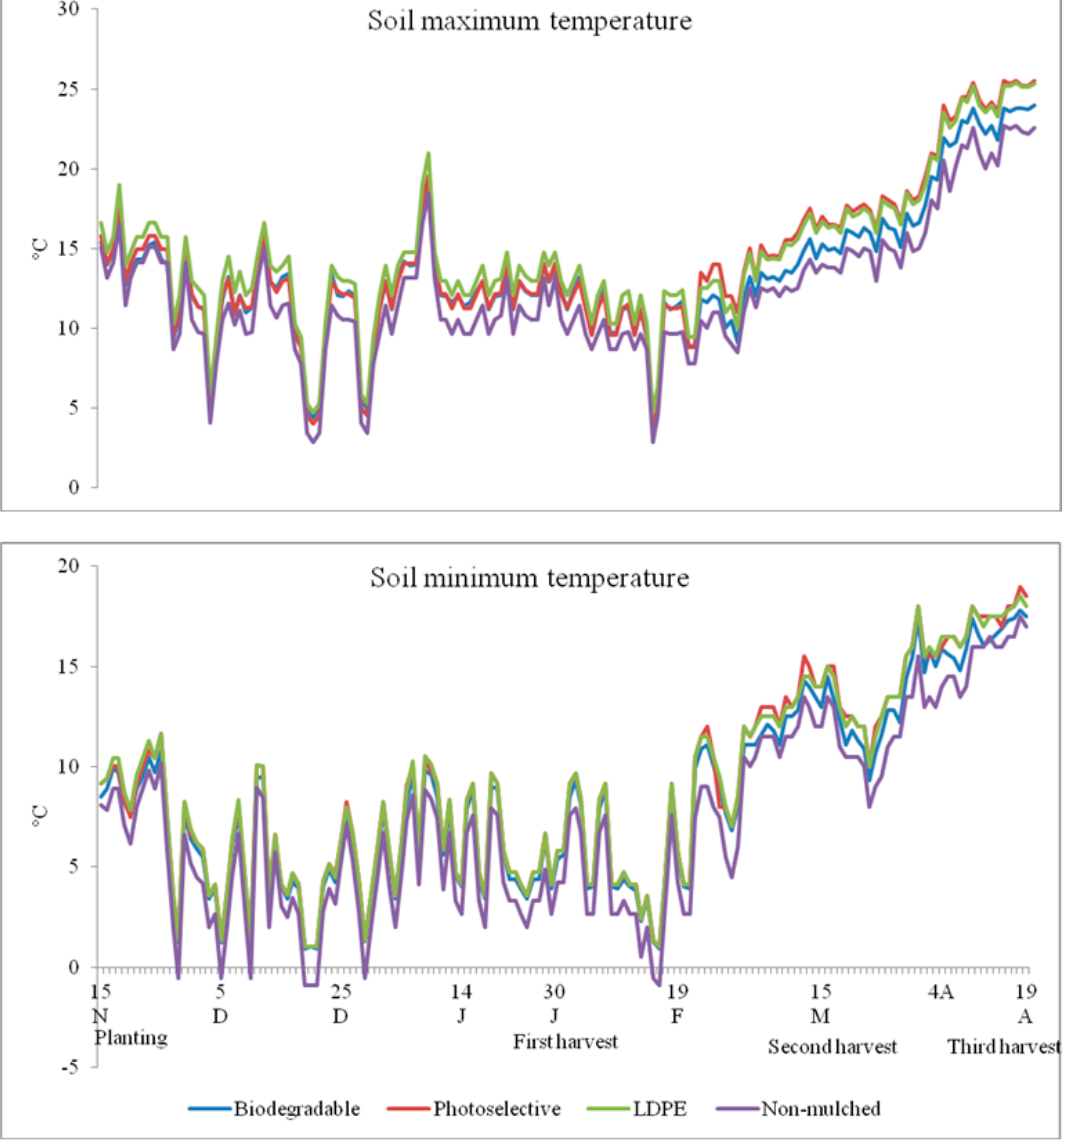
Figure 2. Trend of soil temperature of greenhouse perennial wall rocket grown under different mulching types, as an average of 2016 – 2017 and 2017 –